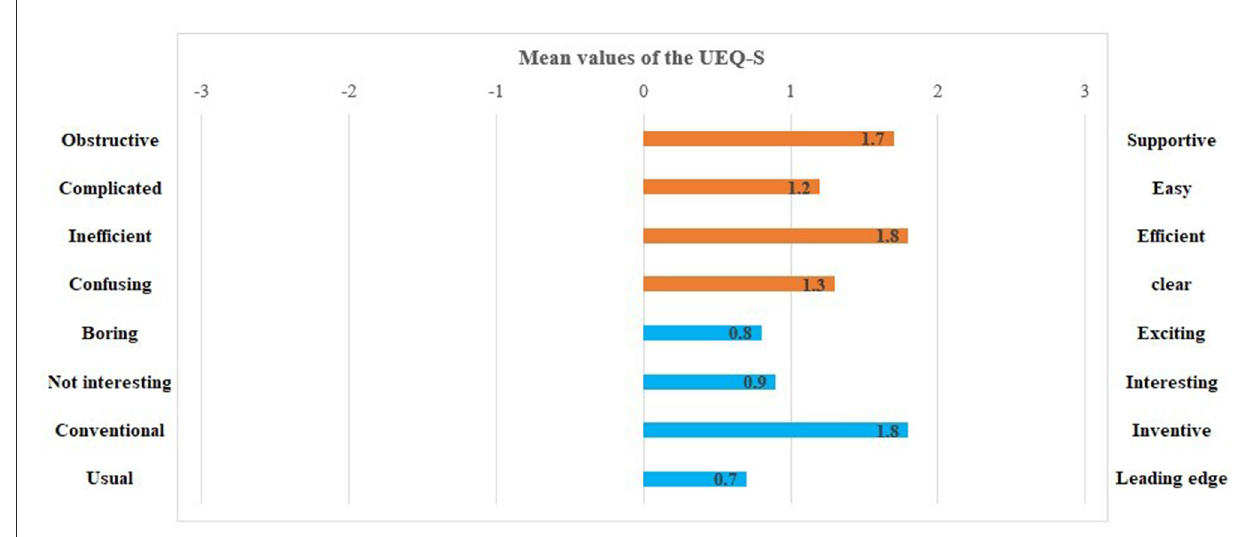
FIGURE4 Mean values of the User Experience Questionnaire items (orange: pragmatic quality; blue: hedonic